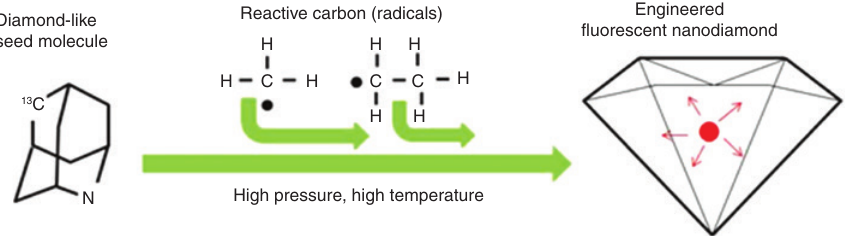
Figure 20: The basic concept of engineered fluorescent nanodiamonds via molecule seeded growth. A diamond-like seed molecule is chosen that has specific atoms arranged in the approximate locations needed to form the color center of interest (the example shown is aza-adamantane with a 13C carbon that could be a precursor for a nitrogen-vacancy quantum register). Carbon radicals (like the methyl and ethyl radicals shown) are then created by cracking a hydrocarbon that decomposes at a much lower temperature than the diamondoid seed molecule. The subsequent growth of a diamond around the seed molecule gives a near-deterministic number and placement of the desired color center, and also assures at least one fluorescent emitter per nanodiamond no matter how small. Adapted from